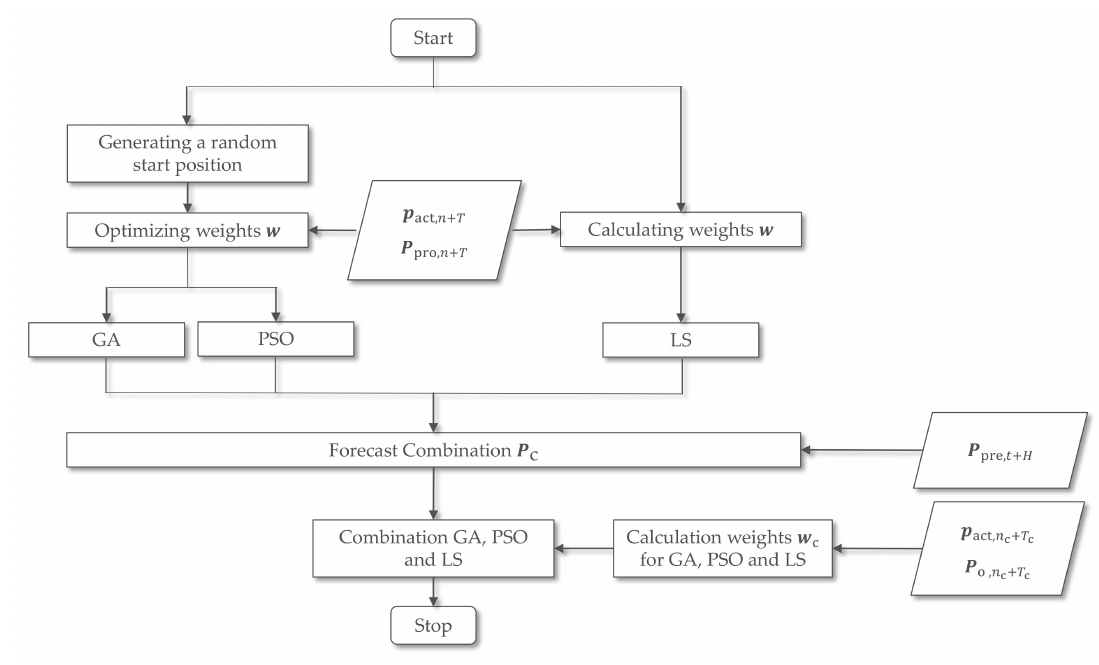
Figure 4. Flowchart of the developed combination